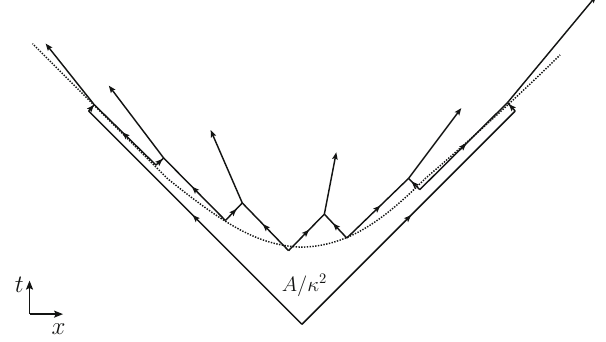
Fig. 1 Breakup of a string between a quark and an anti-quark in a x − t diagram. New q ¯ q pairs are produced around a hyperbola, and combine to the outgoing hadrons. The original q and ¯ q move along light-like trajectories. The area enclosed by the quark lines is the coherence area A in Eq. (2), in units of the string tension κ